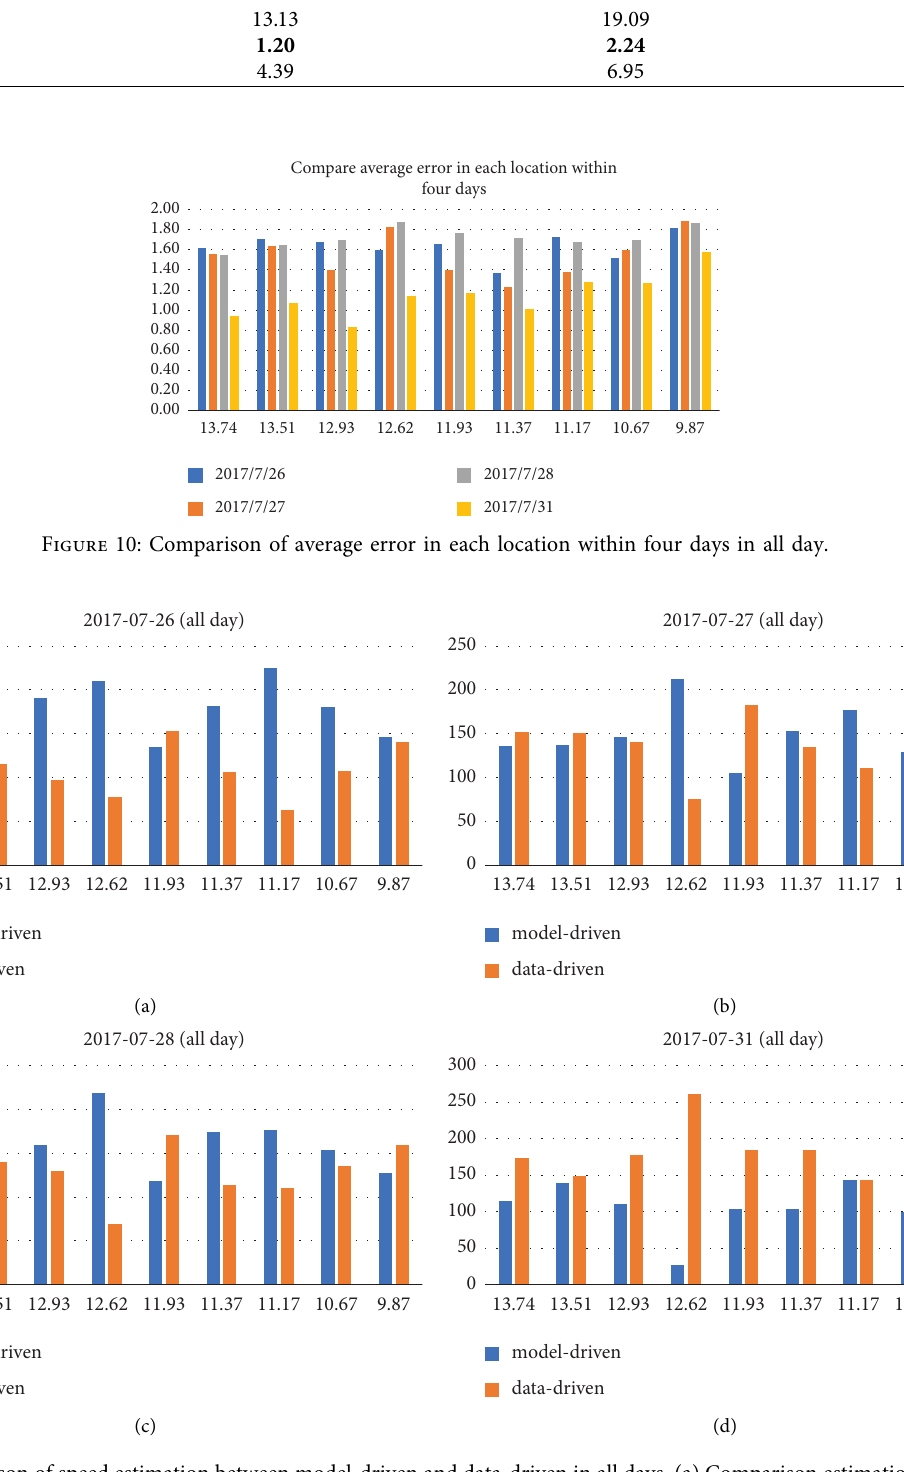
Figure 11: Comparison of speed estimation between model-driven and data-driven in all days. (a) Comparison estimation on 07/26/2017, (b) Comparison estimations on 07/27/2017, (c) Comparison estimation on 07/28/2017, and (d) Comparison estimations on